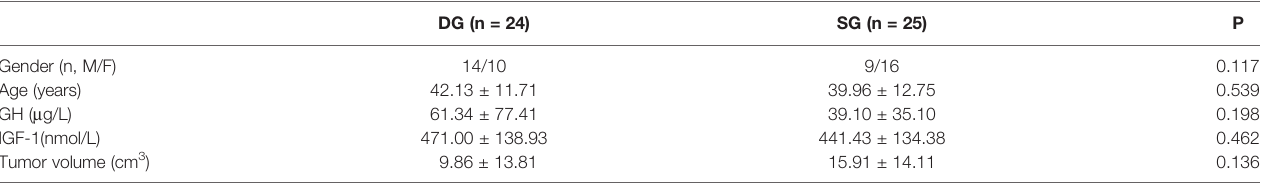
Values denote as (mean ± SD) unless otherwise indicated. DG, densely granulated; SG, sparsely granulated; GH, growth hormone; IGF-1, insulin-like growth